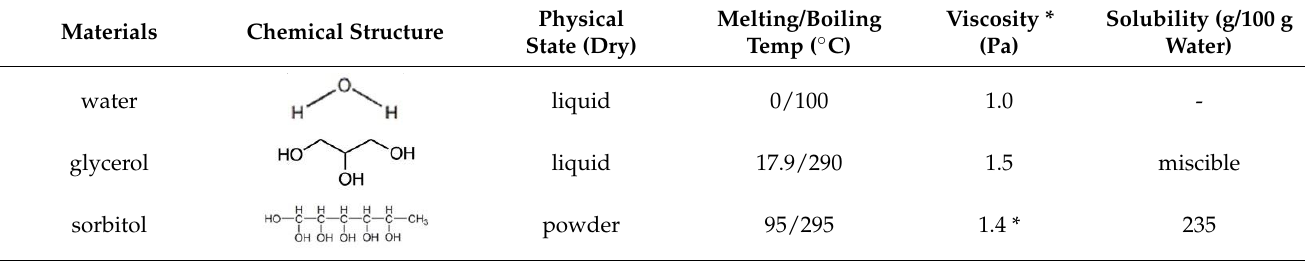
Table 3. Chemical structures and their characterizations of various plasticizers used in this work.